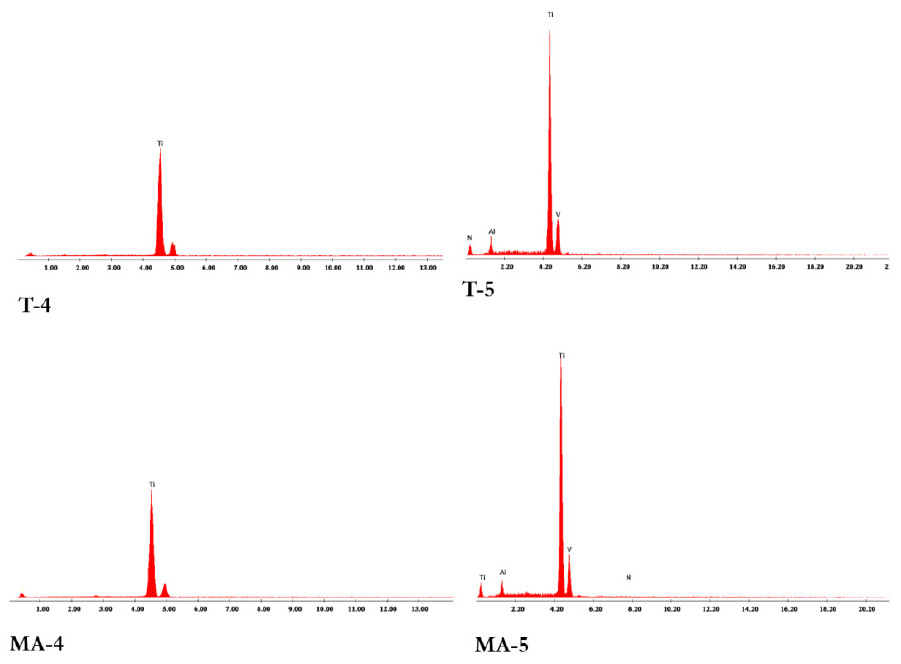
Figure 2. Energy Dispersive X-ray Spectrometry (SEM/EDS) analysis of the turned grade 4 ( T-4 ), turned grade 5 ( T-5 ), mildly acid-etched grade 4 ( MA-4 ), and mildly acid-etched grade 5 ( MA-5 ) Ti titanium surfaces.